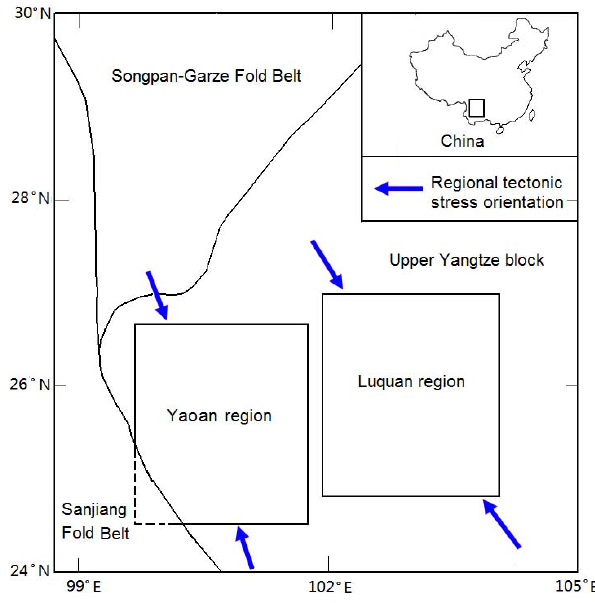
Fig. 2. Locations of the Luquan and Yaoan regions and the regional tectonic stress orientations. The azimuths of tectonic stress orienta- tion (the greatest compressive stress direction) of the Luquan and Yaoan regions are 148 ◦ and 165 ◦ , respectively, according to the study by Qian et al. (2011).